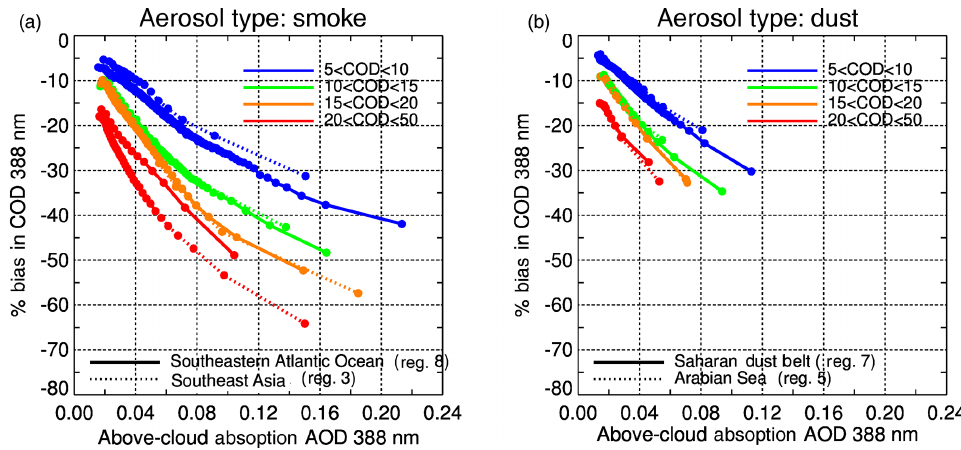
Figure 11. Percent difference in COD (aerosol-corrected minus non-corrected) as a function of above-cloud absorption AOD (388nm) for the smoke (a) and dust (b) dominated regions. Different color codes represent the relationship for a discrete range of aerosol-corrected